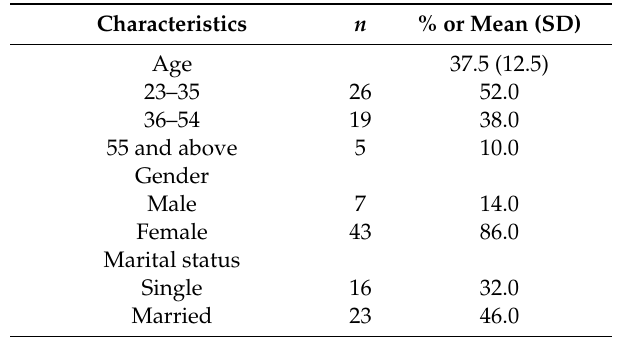
Table 1. Demographic characteristics of study participants ( N =